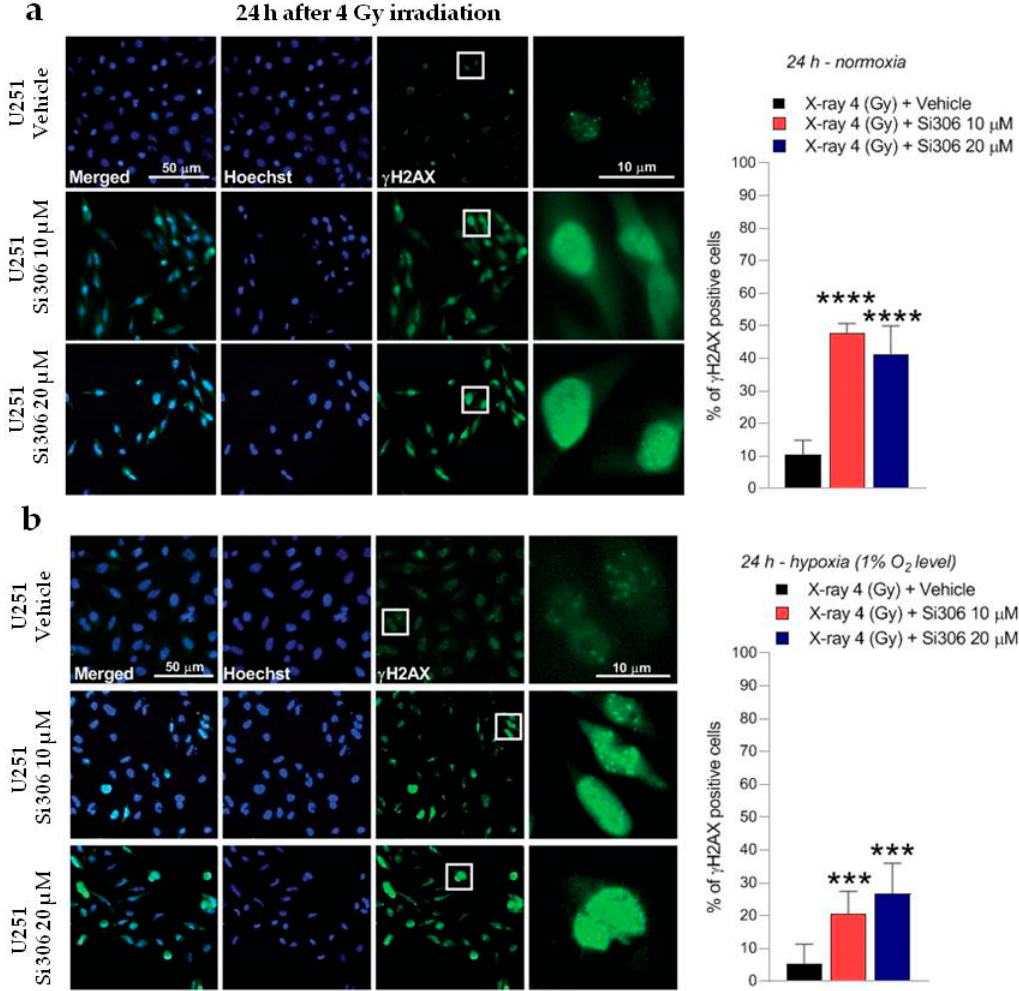
Figure 6. Representative pictures with inserts (white squares) and quantification of U251-MG positive cells for γ H2AX realized 24 h after 4 Gy irradiation normoxia ( a ) and in hypoxia ( b ). Data are mean ± SD of n = 3 independent experiments; *** p -value < 0.001 and **** p -value < 0.0001 versus 4 Gy + vehicle (F normoxia = 87.81, p -value < 0.0001; F hypoxia = 18.87, p -value < 0.0001. One-way ANOVA with Holm–Šídák post-hoc test).